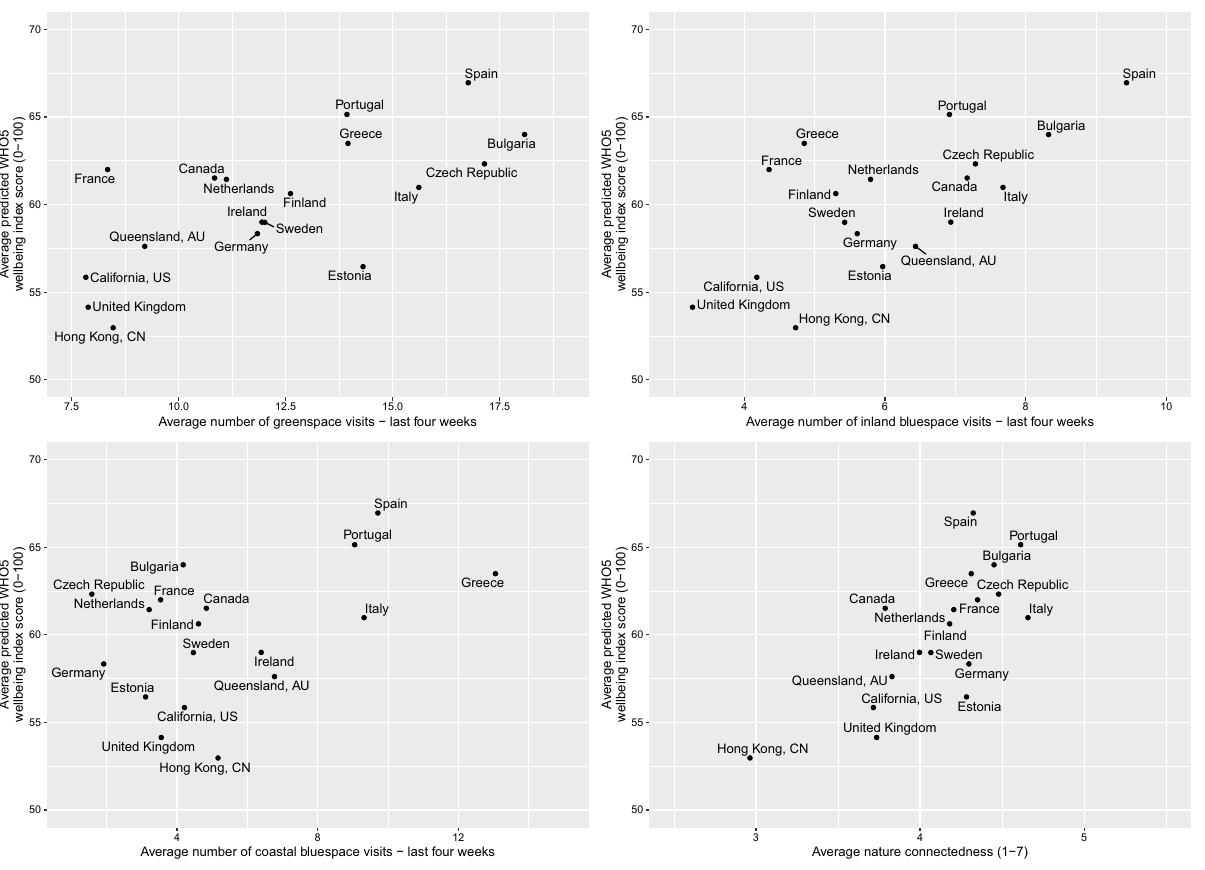
Figure 3. Country level relationships between positive well-being (0–100) and: ( a ) Green space visits in last 4 weeks; ( b ) Inland-blue space visits in last 4 weeks; ( c ) Coastal-blue space visits in last 4 weeks and ( d ) nature connectedness (1–7). Plots are based on aggregated predicted values across countries from our original mixed models controlling for residential exposure visit frequencies to alternative locations, connectedness ( a – c ), age, gender, employment status, household income, longstanding-illness, relationship status, education level, household composition, dog ownership, car ownership, physical activity, and season (sample